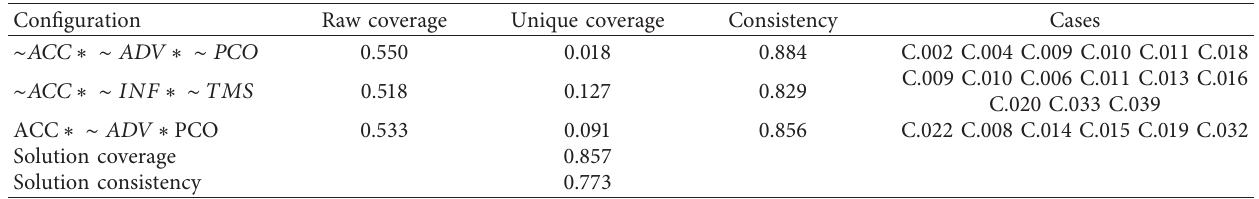
Table 4: Truth table minimization results for the negative impact of BIM usage satisfaction.